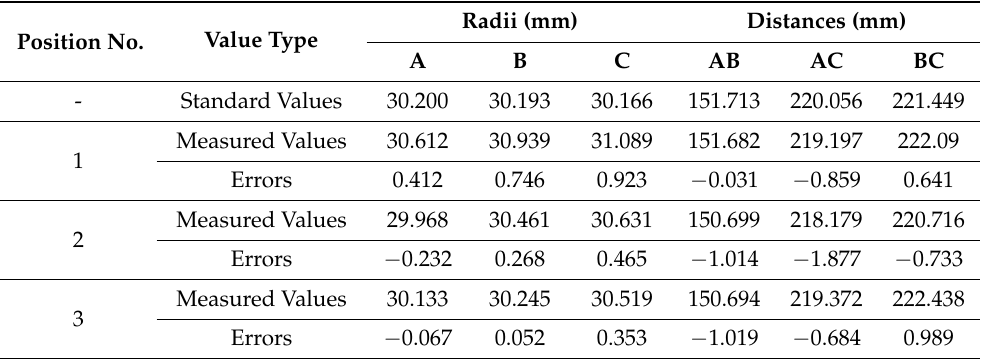
Table 2. Summary of the fitted radii and distances values of the three-ball system. The errors between the fitted values and the standard values are also listed. Radii Position No. Value Type Position No.